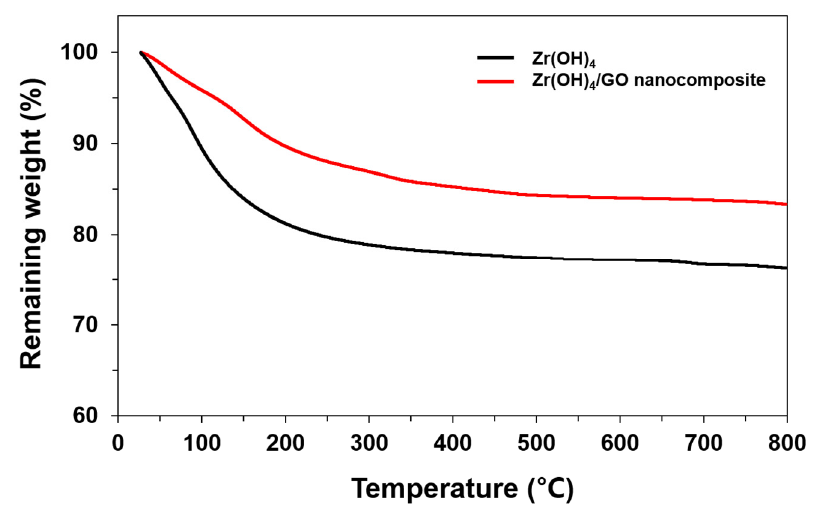
Figure 3. Profiles of thermogravimetric analysis (TGA) of Zr(OH) 4 / GO nanocomposite and pristine Zr(OH) 4 . The loss percentages of Zr(OH) 4 / GO nanocomposite and Zr(OH) 4 are 17% and 24%, respectively. All samples were heated at 30 to 800 °C with a heating rate of 5 °C / min under N 2 gas.